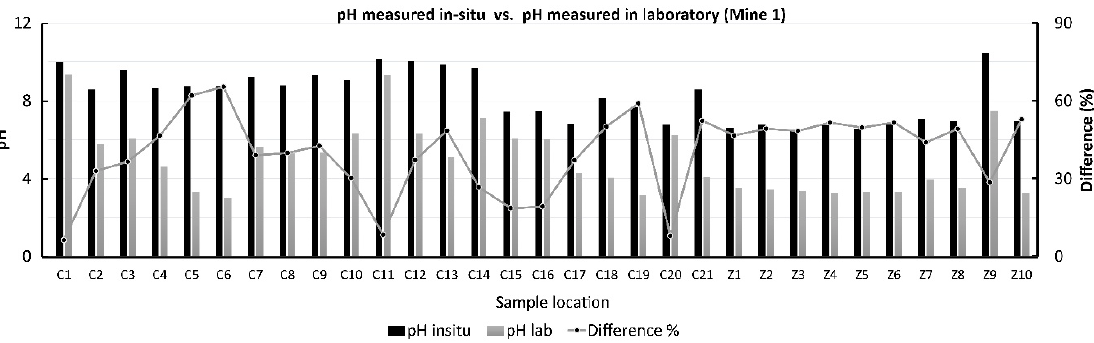
Figure 6. The pH measured in the laboratory vs. pH measured in situ.